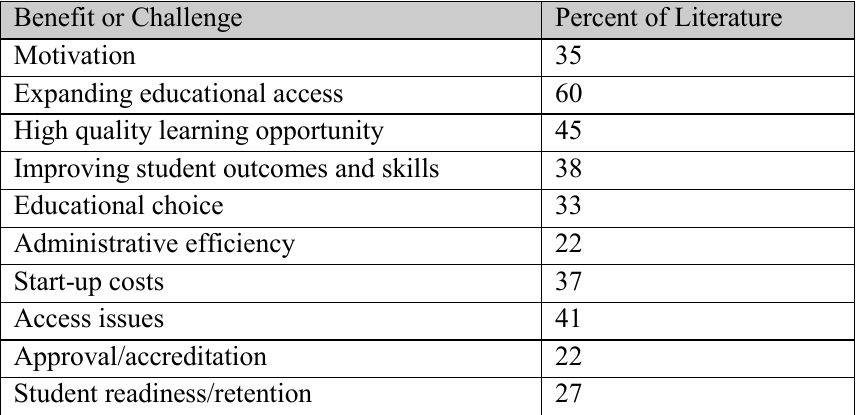
Percentage of Literature about Various Benefits and Challenges Benefit or Challenge Percent of